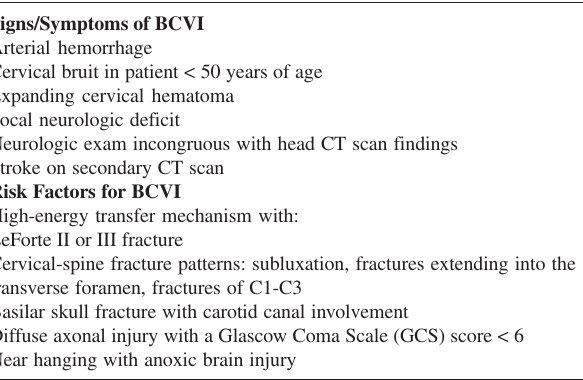
Table 1- Denver screening criteria for blunt cerebrovascular injury (BCVI)